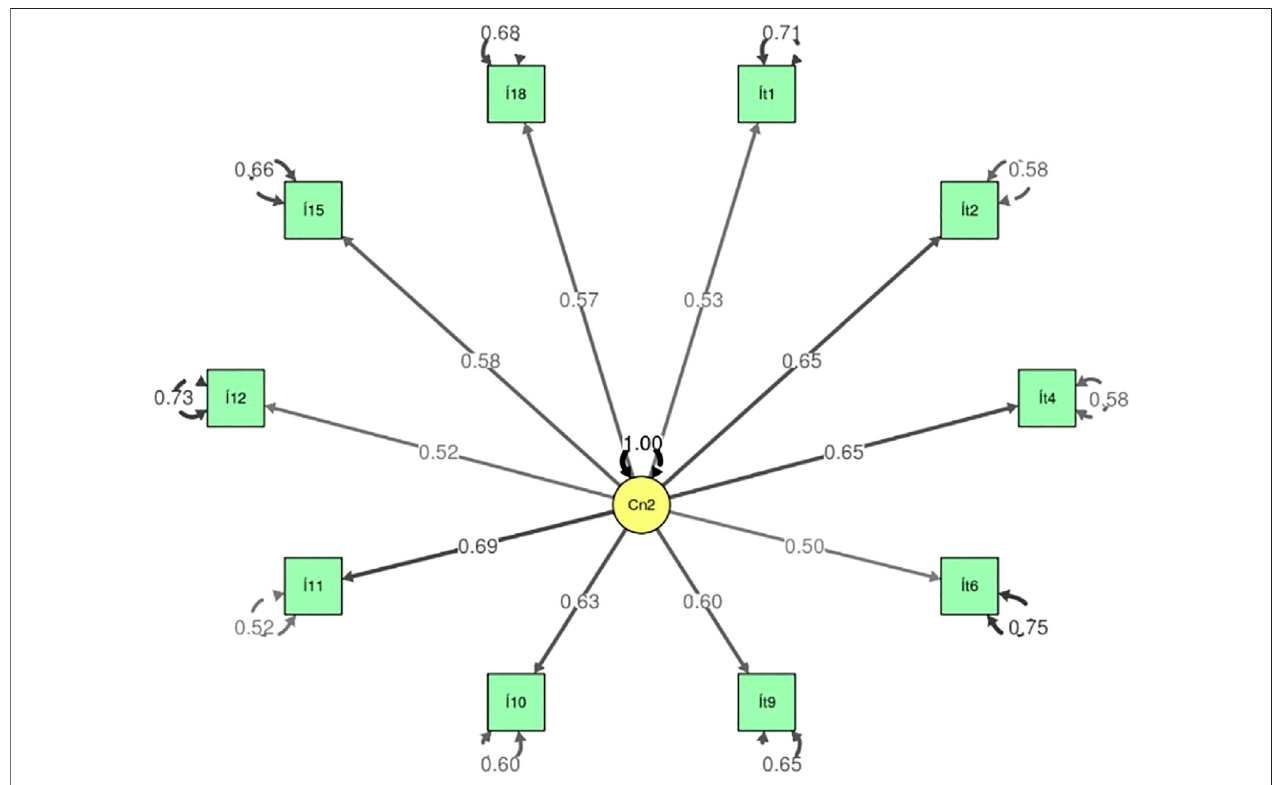
FIGURE 2 | Structural equation model. Factor